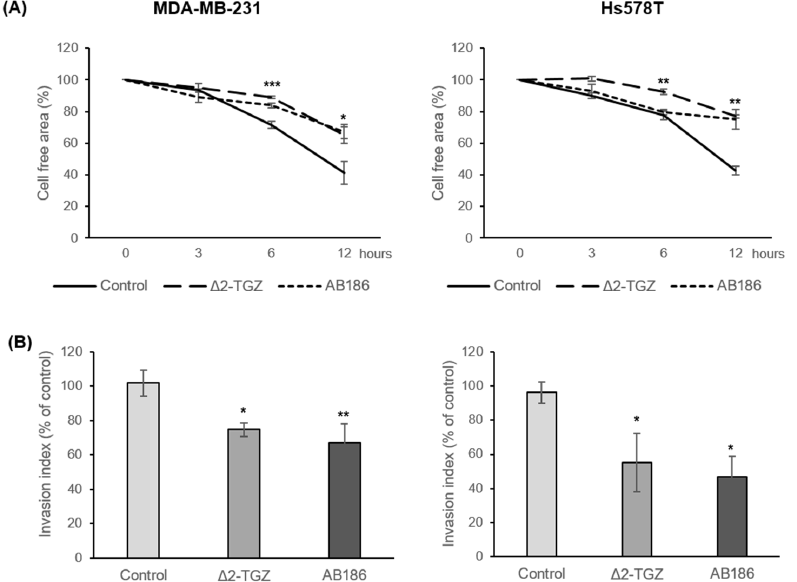
Figure 6. TGZ derivatives alter migration properties of MDA-MB-231 and Hs578T cells. MDA-MB- 231 and Hs578T cells were exposed to DMSO as control, or 20 µ M of ∆ 2-TGZ or 4 µ M of AB186 and subjected to wound healing ( A ) or transwell migration ( B ) assays. ( A ) Cell free area was